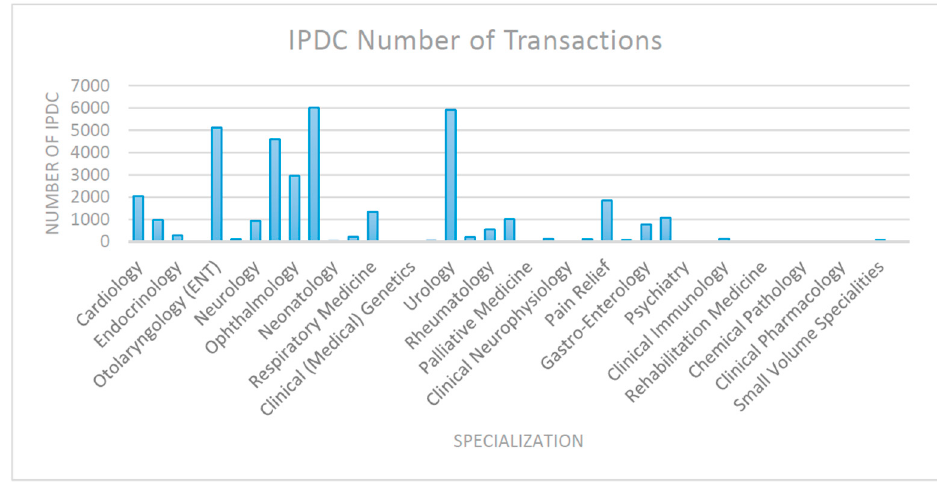
Figure 12. Number of IPDC and their transaction across different departments/speciality.